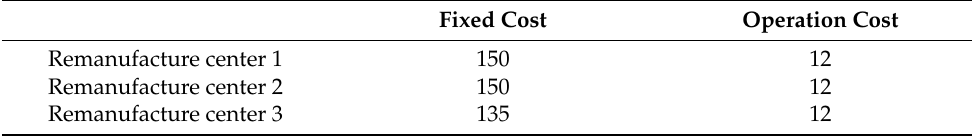
Table 3. Parameters related to remanufacturing centers.